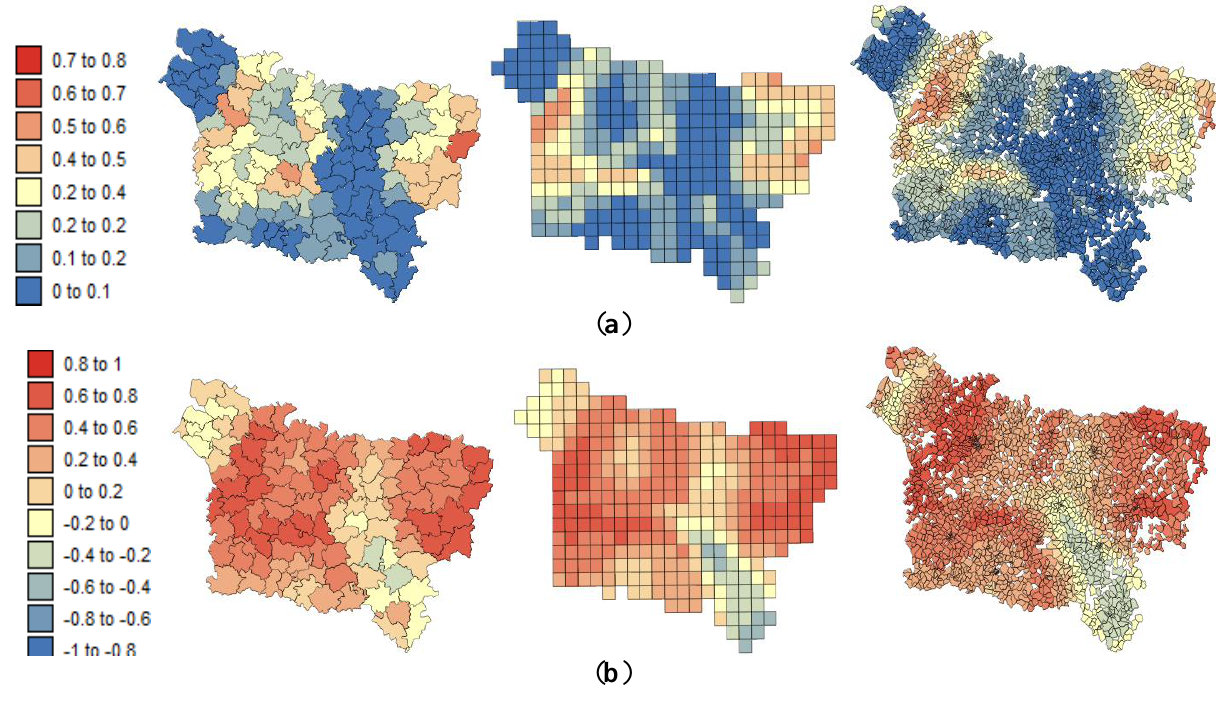
Figure 9. Results of the geographically weighted regression applied to the pleural cancer mortality kriged rates: ( a ) maps of the proportion of variance explained by the exposure inhalation indicator (R 2 ); ( b ) maps of the local correlation coefficients with the exposure inhalation